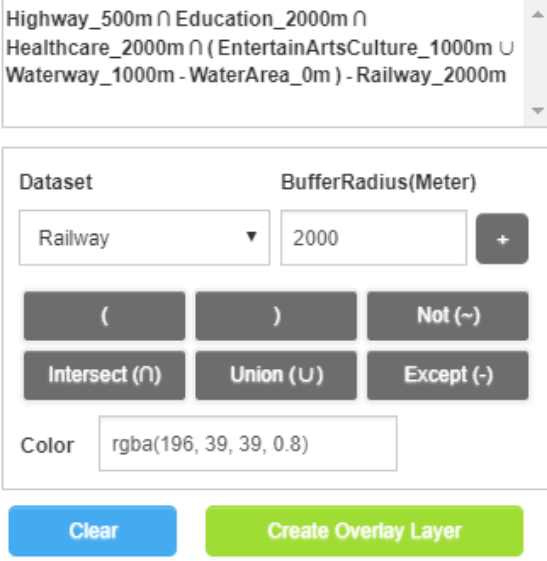
Figure 8. Input of the housing site selection in Spain.